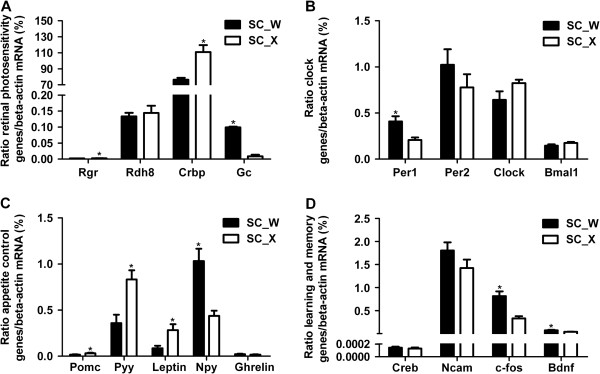
Validation of differentially expressed genes with Real-time RT-PCR. A. The relative mRNA abundance of retinal photosensitivity genes (Rgr, Rdh8, Crbp and Gc) in feeders and nonfeeders was determined by Real-time RT-PCR. Compared with nonfeeders, the mRNA levels of Rgr and Crbp were significantly increased, whereas Gc was decreased significantly. B. The relative mRNA abundance of clock genes (Per1, Per2, Clock and Bmal1) in feeders and nonfeeders was determined by Real-time RT-PCR. Compared with nonfeeders, the mRNA levels of Per1 and Per2 were decreased significantly and slightly, respectively, whereas Clock and Bmal1 were slightly increased. C. The relative mRNA abundance of appetite control genes (Pomc, Pyy, leptin, Npy and ghrelin) in feeders and nonfeeders was determined by Real-time RT-PCR. Compared with nonfeeders, the mRNA levels of Pomc, Pyy and leptin were significantly increased, whereas Npy and ghrelin were decreased significantly and slightly, respectively. D. The relative mRNA abundance of learning and memory genes (Creb, Ncam, c-fos and Bdnf) in feeders and nonfeeders was determined by Real-time RT-PCR. Compared with nonfeeders, the mRNA levels of Creb and Ncam were slightly decreased, c-fos and Bdnf were decreased significantly. Data are presented as mean ± standard error (n = 6). * indicates significant differences between groups based on one-way analysis of variance (ANOVA) followed by the post hoc test (P < 0.05).